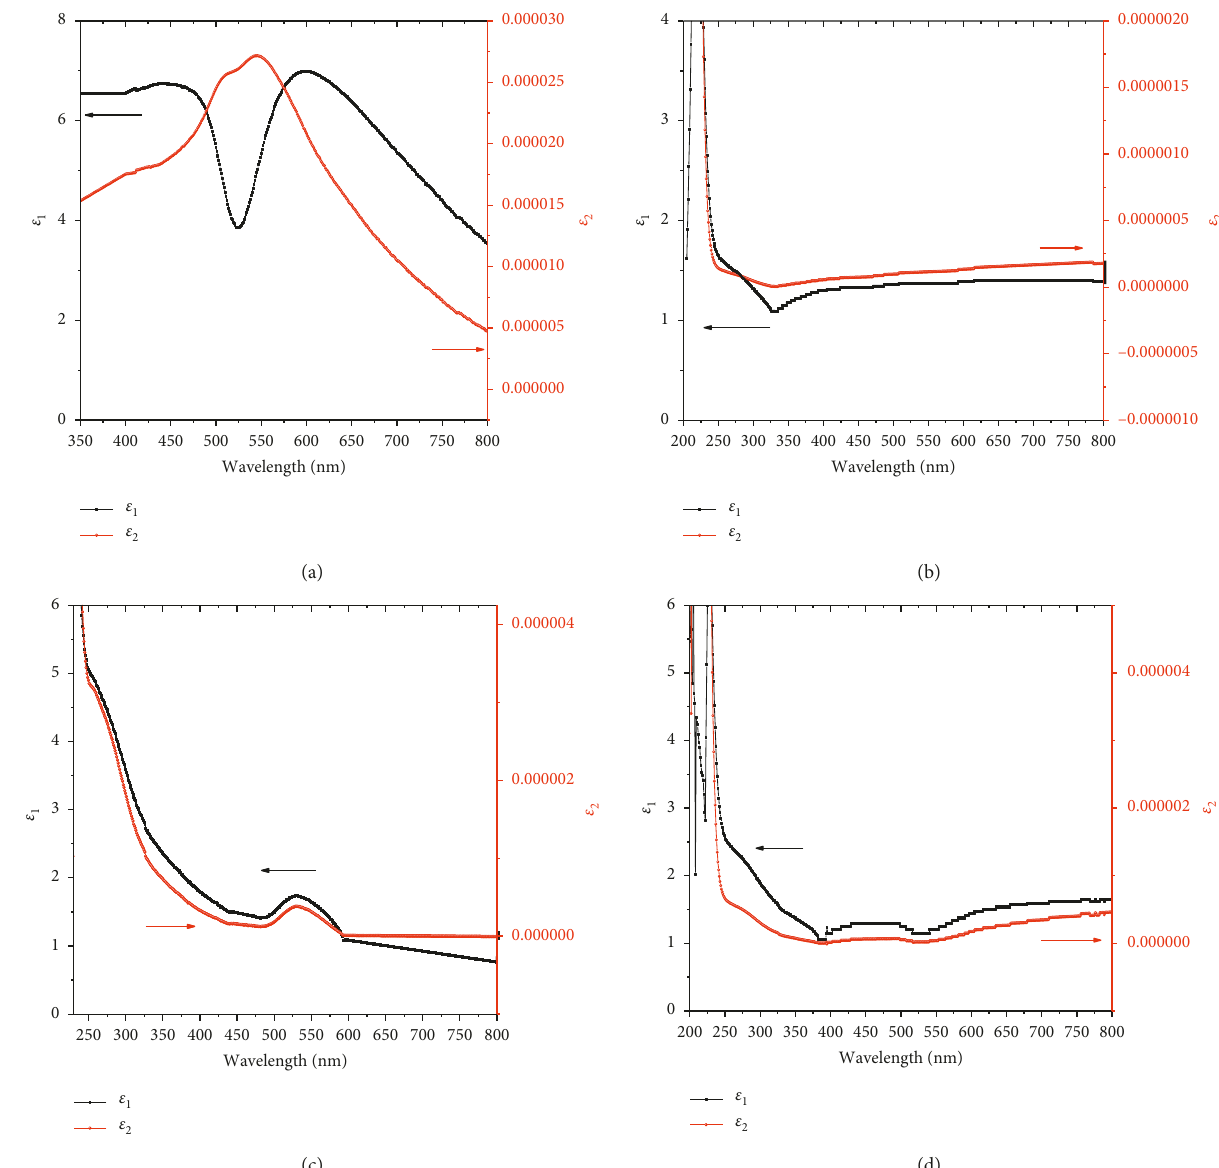
Figure 6: The relationship between ε 1 and ε 2 with wavelength in the water